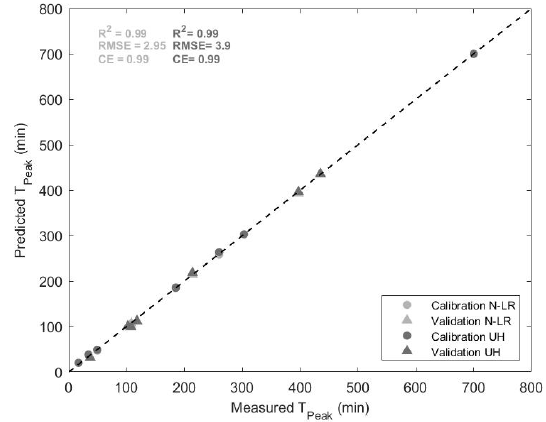
Figure 8. Comparison plot between measured and predicted time to peak T peak , for N-LR (light grey) and UH (dark grey) model in either calibration (solid circle) or validation (solid triangle) step.